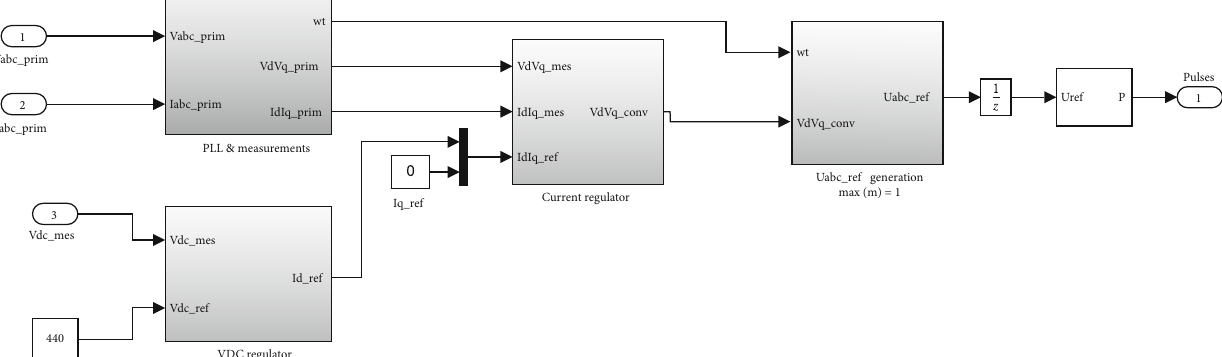
Figure 22: DNN controller-based voltage source controller for smart